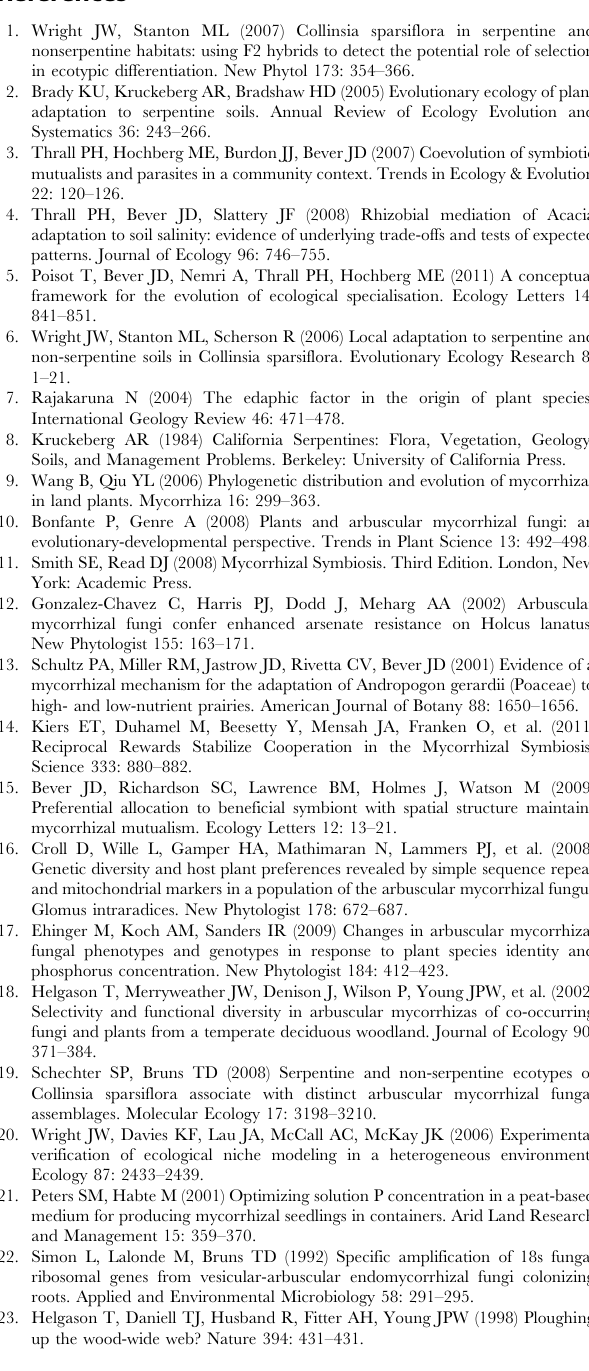
Table S1 Soil chemical variables (S=serpentine, NS=non-serpen- tine, and CG=common garden soil). Values are means with standard deviation below in parentheses. Nitrogen (as NO 3 ) phosphorus (P, Weak Bray), potassium (K), magnesium (Mg), calcium (Ca), zinc (Zn), iron (Fe), copper (Cu), and boron (B) are reported in parts per million (ppm). Cation exchange capacity (CEC) is reported as milliequivalents per 100 grams of soil. Highlighted numbers indicate Ca:Mg ratio; serpentine soils have a ratio much less than one and non-serpentine soils have ratios greater than one. Different letters within a column indicate significant differences at P , 0.05.